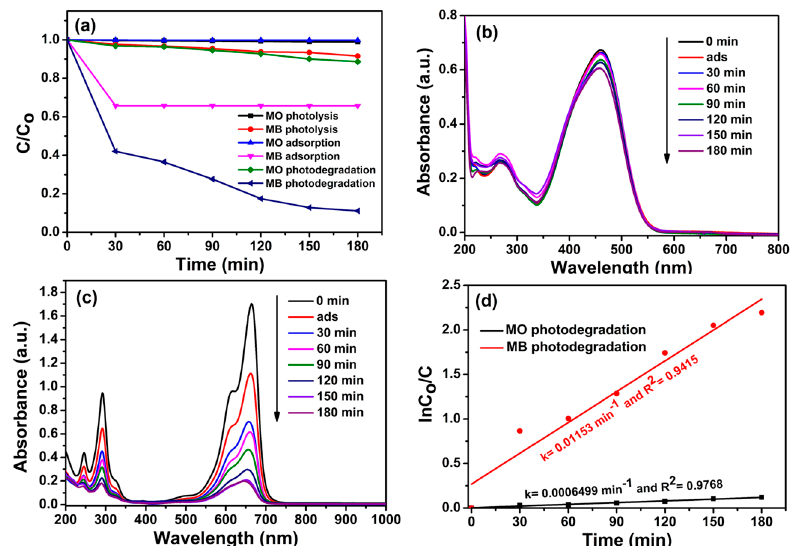
Figure 7. ( a ) Degradation of methyl orange (MO) and methylene blue (MB) by photolysis, adsorption and photocatalysis, the concentration of MB and MO was 10 ppm, the dosage of SCNPNS was 50 mg/100 mL, and the irradiation source was visible light. Changes of UV–visible absorption spectra of ( b ) MO and ( c ) MB during the course of reaction. ( d ) Kinetics of MO and MB photodegradation by the aqueous SCNPNS under visible light.